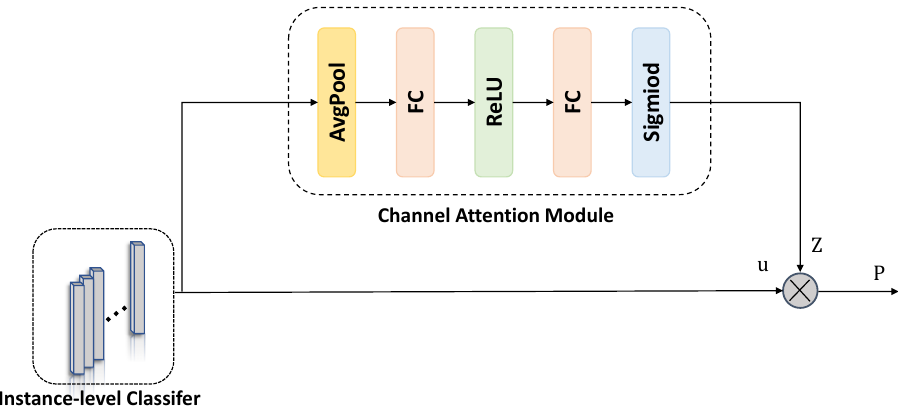
Figure 6. Structure of MIL pooling based on channel